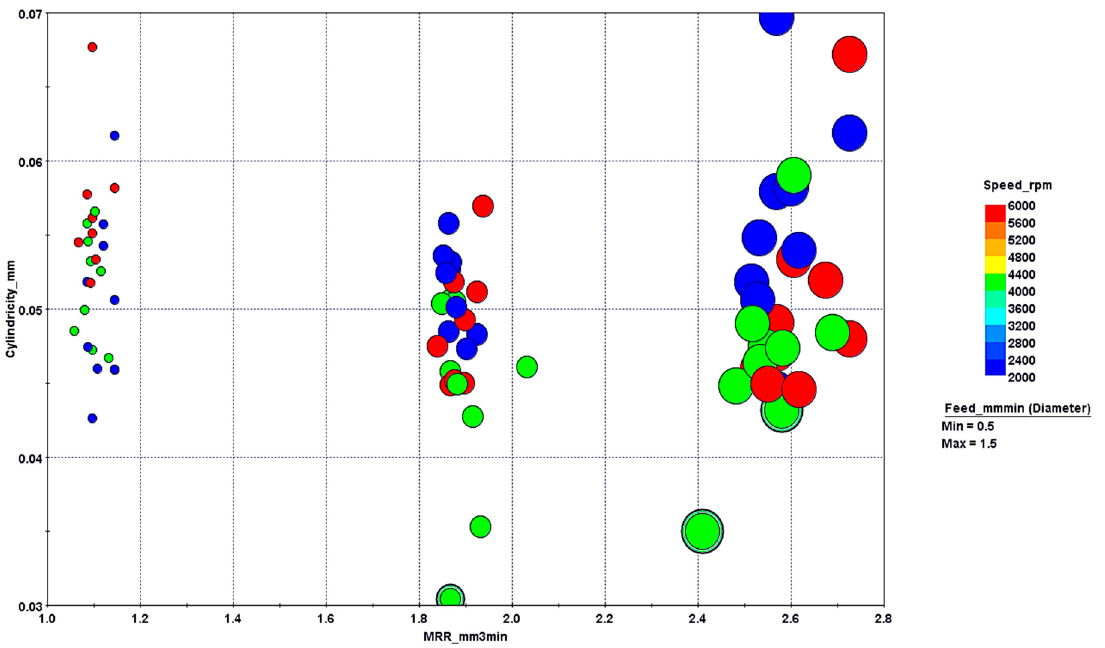
Figure 14. 3D bubble chart with design points.